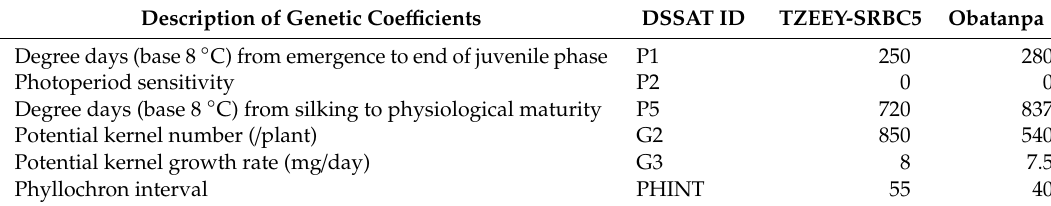
Table 3. Genetic coe ffi cients of the maize varieties